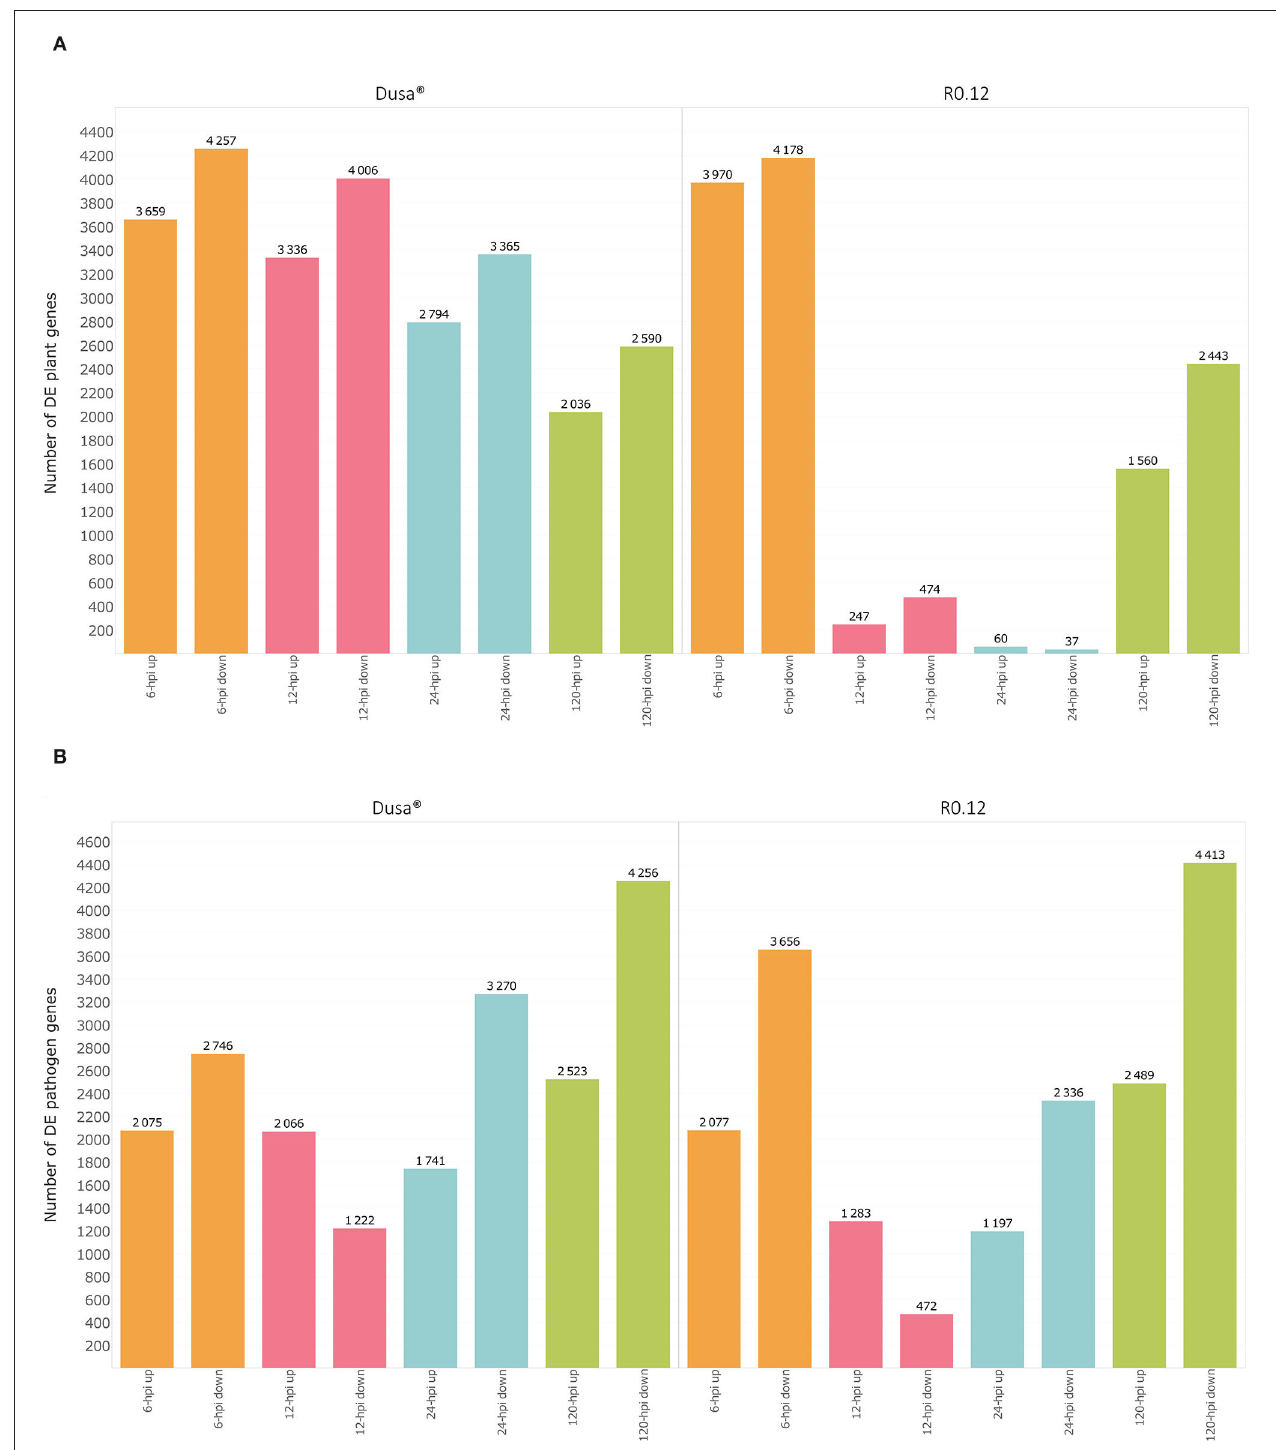
FIGURE 1 | Graphical representation of differentially expressed genes (DEGs) over time in both a susceptible (R0.12) and a partially resistant (Dusa ® ) rootstock inoculated with Phytophthora cinnamomi . (A) Total number of significantly up- [log 2 (fold change) > 1, p = 0.05] and downregulated avocado genes [log 2 (fold change) < − 1, p = 0.05] in P. cinnamomi- inoculated rootstocks as compared to mock-inoculated controls, shown at 6, 12, 24, and 120h post inoculation (hpi) in both partially resistant and susceptible avocado rootstocks. (B) Total number of significantly up- [log 2 (fold change) > 1, p = 0.05] and downregulated P. cinnamomi genes [log 2 (fold change) < − 1, p = 0.05] in inoculated avocado rootstocks as compared to in vitro mycelial controls, over time in both Dusa ® and R0.12.